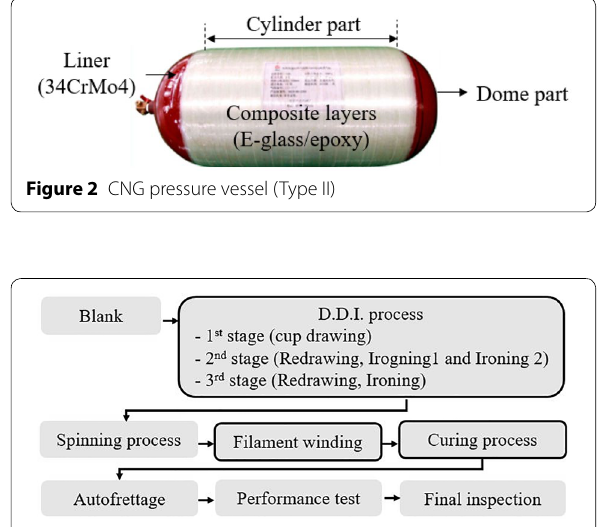
Figure 3 Manufacturing process of CNG pressure vessel (Type